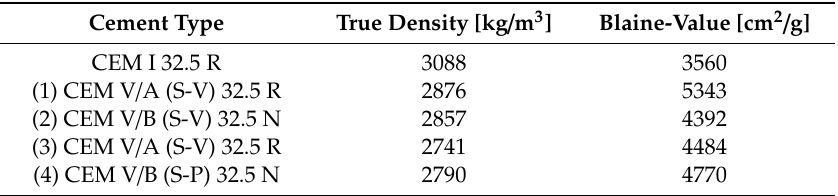
Table 3. Cement true density and Blaine value.